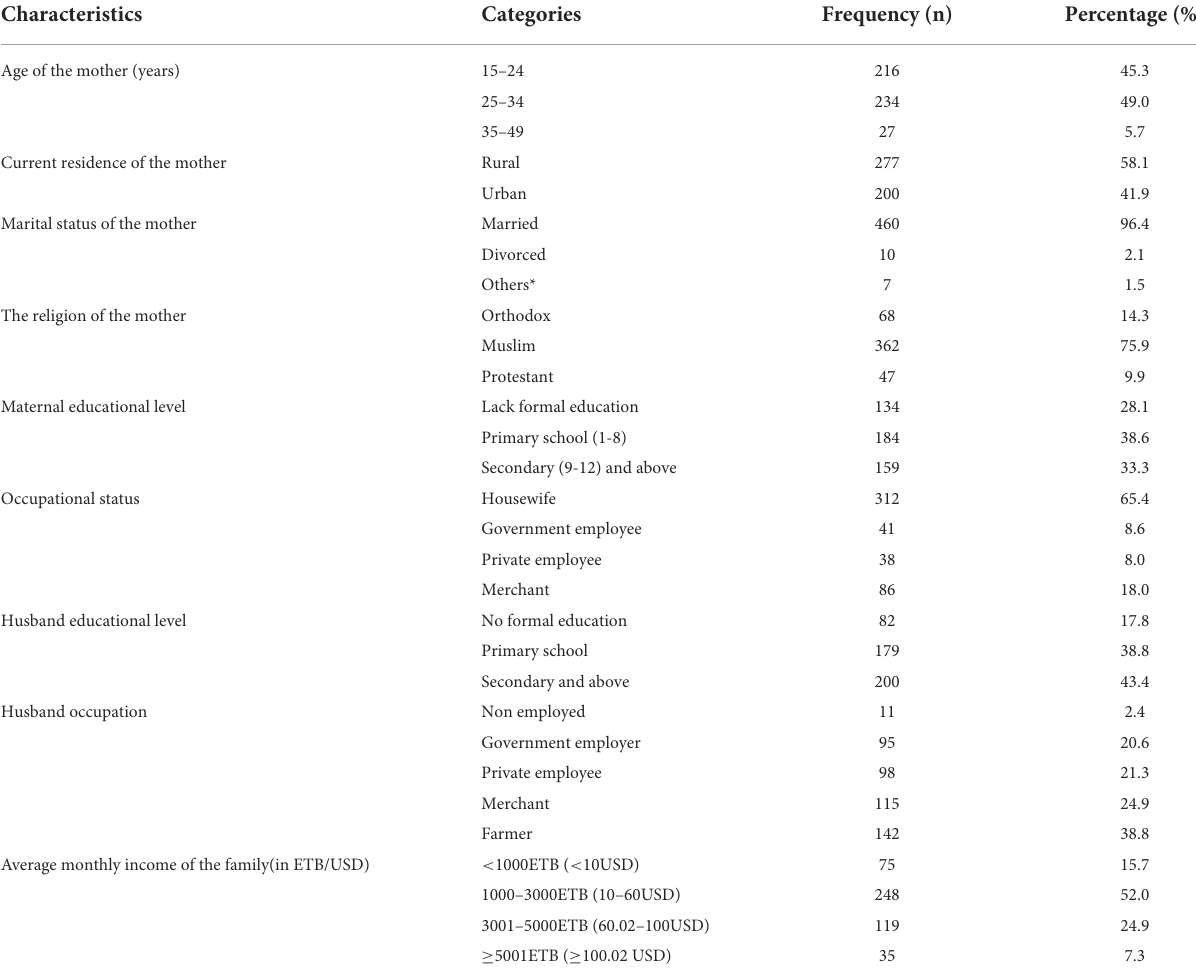
TABLE 1 Socio-demographic characteristics of postpartum women admitted to the maternity ward in public hospitals in Harari Regional State, Eastern Ethiopia, 2021 ( n = 477). Characteristics